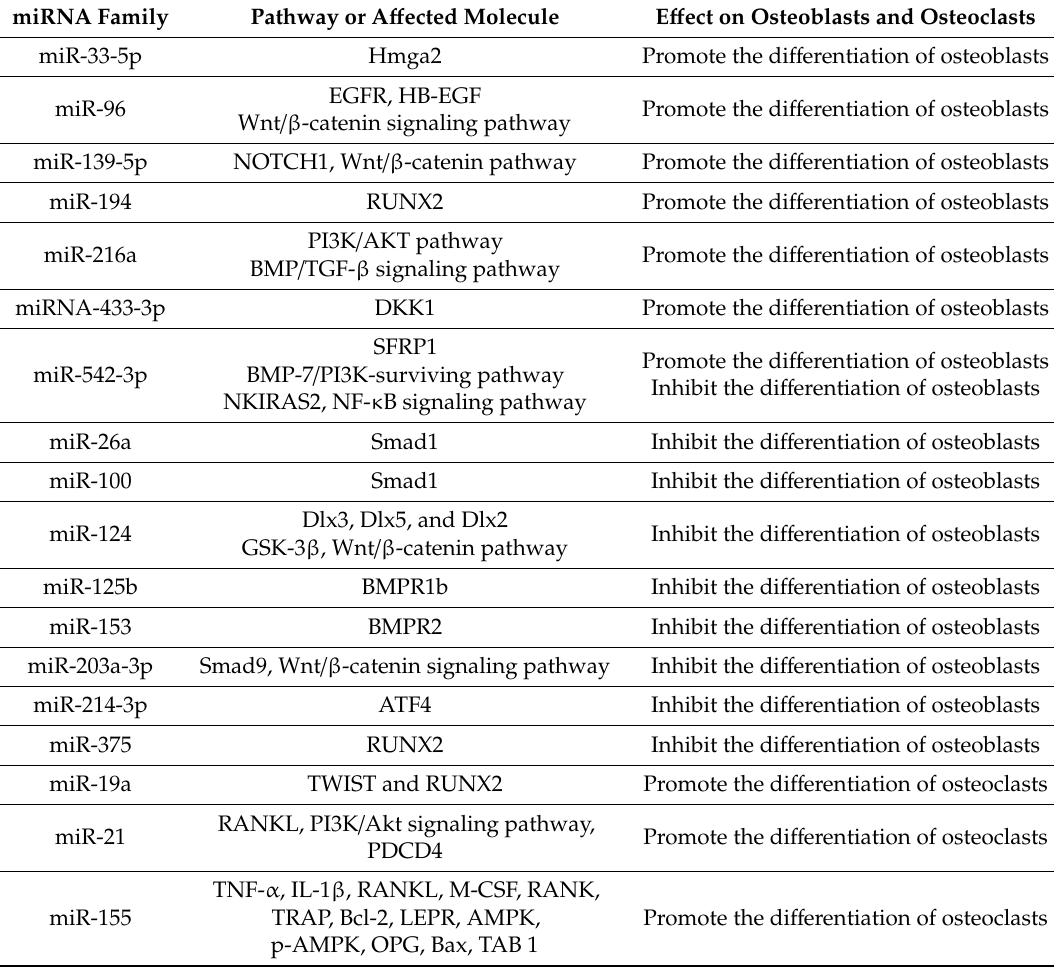
Table 3. The pathway / a ff ected molecule of miRNAs and their e ff ects on bone